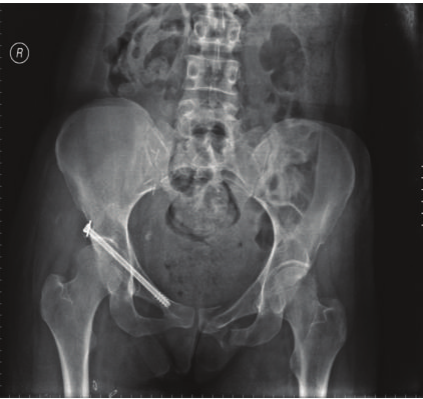
Figure 3: Postoperative X-ray: percutaneous fixation of anterior column fracture via 7,3 cannulated screw.